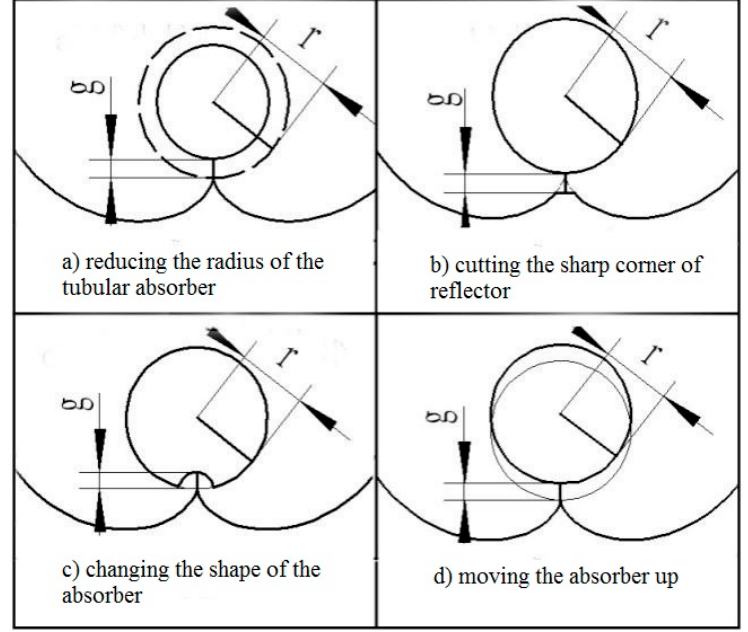
Figure 2. Four ways to create gaps in CPC. ( a ) Reducing the radius of the tubular absorber; ( b ) cutting the sharp corner of the reflector; ( c ) changing the shape of the absorber; ( d ) moving the absorber up [27].